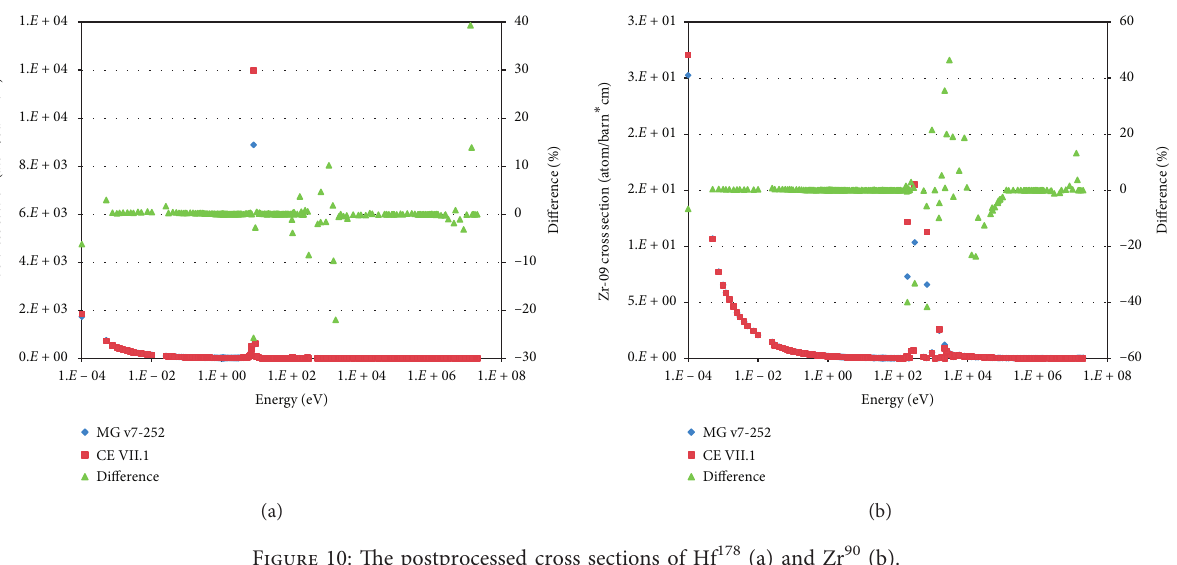
Figure 10: The postprocessed cross sections of Hf 178 (a) and Zr 90 (b).